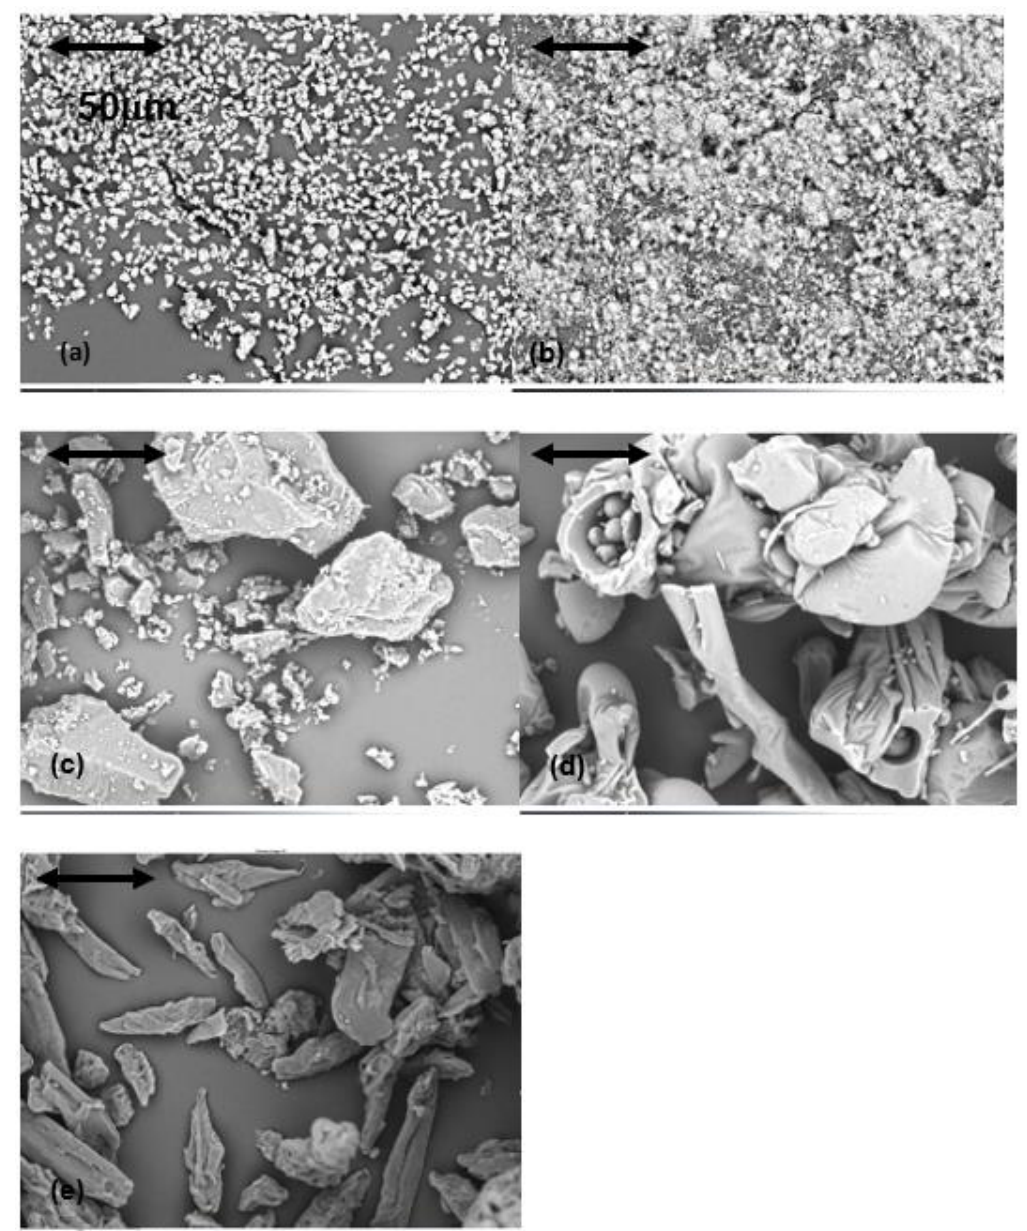
Figure 6. Scanning electron micrographs (SEM) of ( a ) CRM limestone, ( b ) calcium phosphate, ( c ) lactose, ( d ) maltodextrin, and ( e ) JRS Easytab, compared with a 50 μm scale.